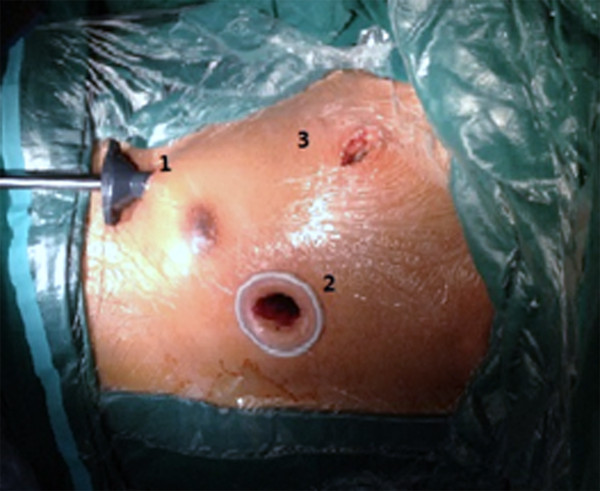
Surgical incisions and portal sites.